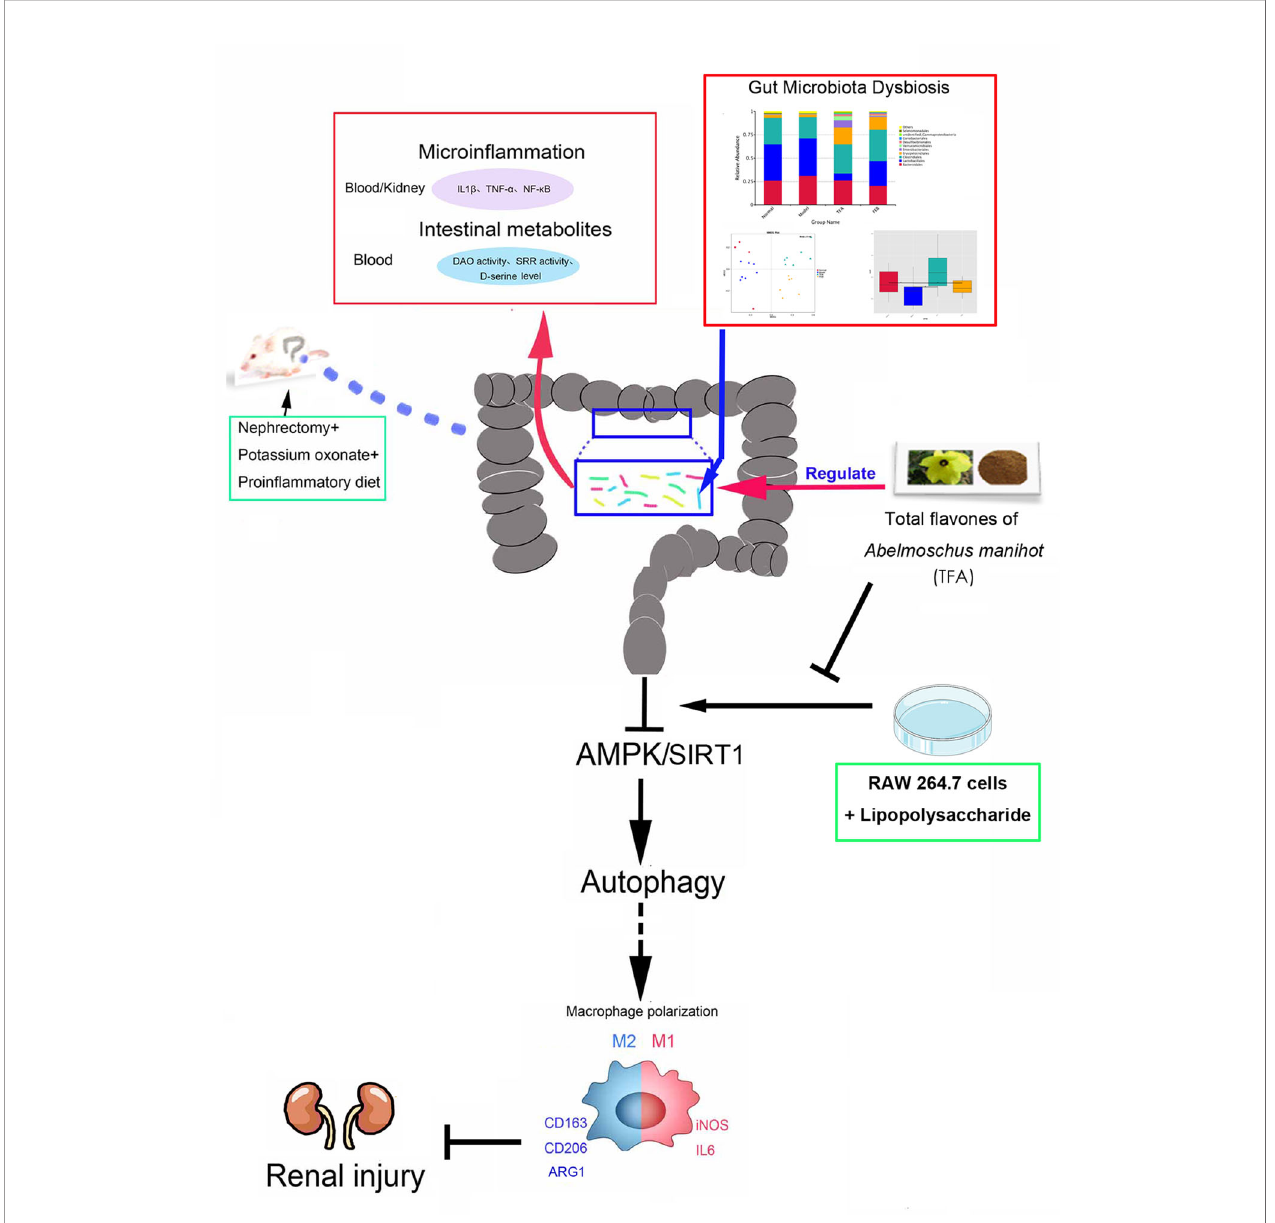
FIGURE 9 | Schematic diagram of TFA remodeling gut microbiota and inhibiting microin fl ammation in CRF progression. TFA, total fl avones of Abelmoschus manihot ; CRF, chronic renal